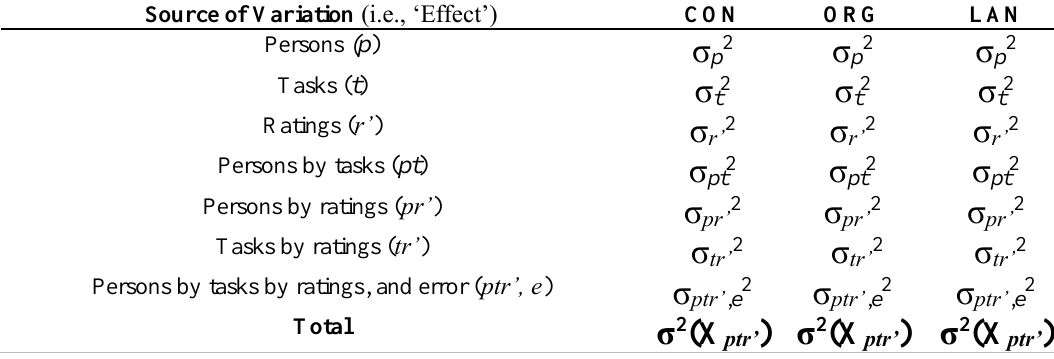
Two-Facet, Fully Crossed Design with Fixed Facets (Variance